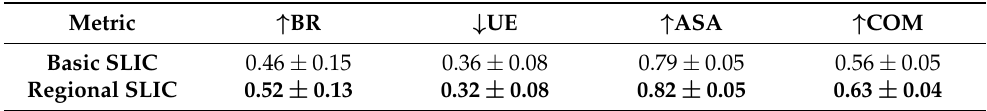
Table 1. Basic and regional SLIC performances on the Prague dataset. Arrows denote the metric direction (the higher ↑ or smaller ↓ , the better), and best results are in bold.